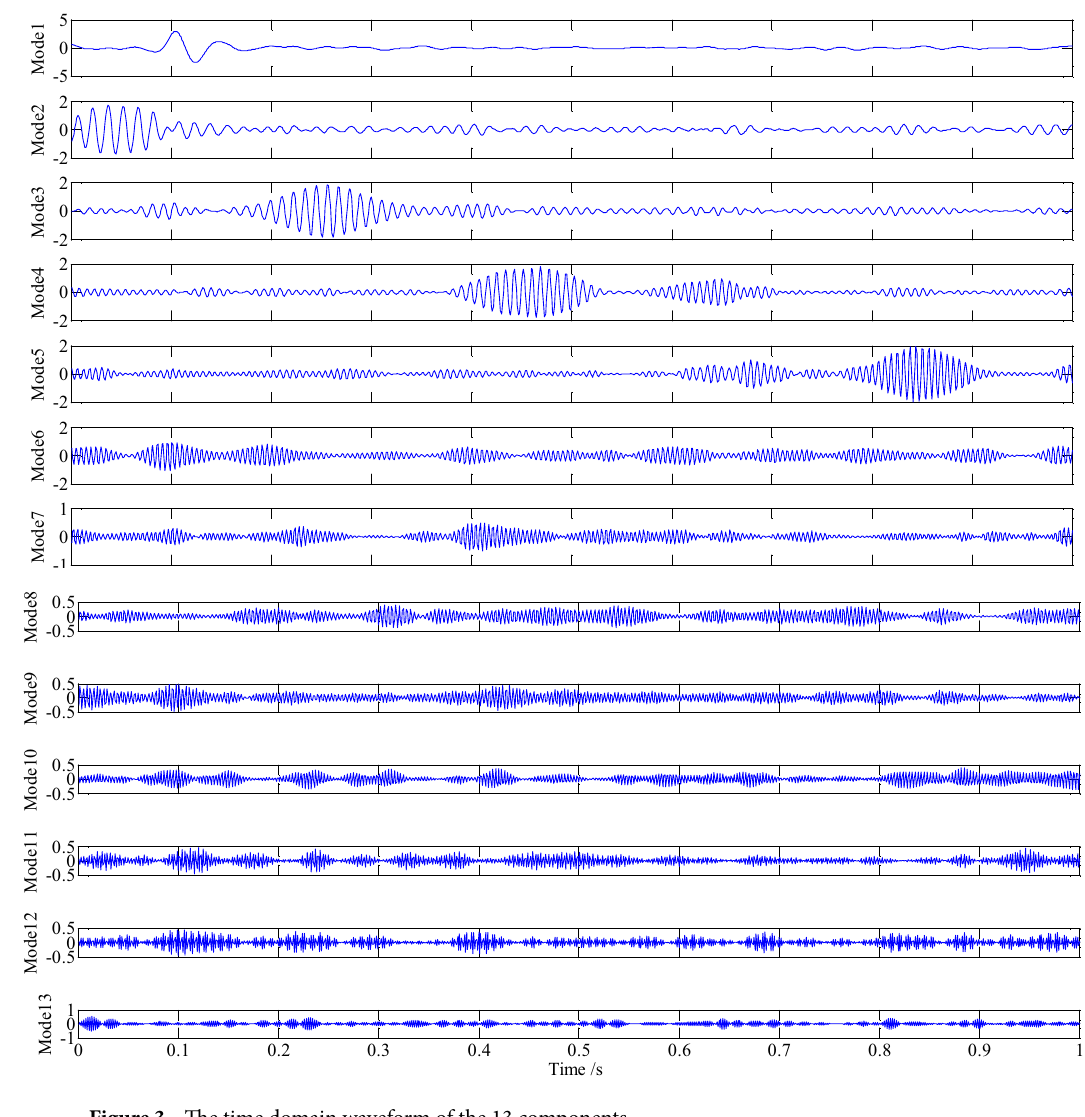
Figure 3. The time domain waveform of the 13 components.